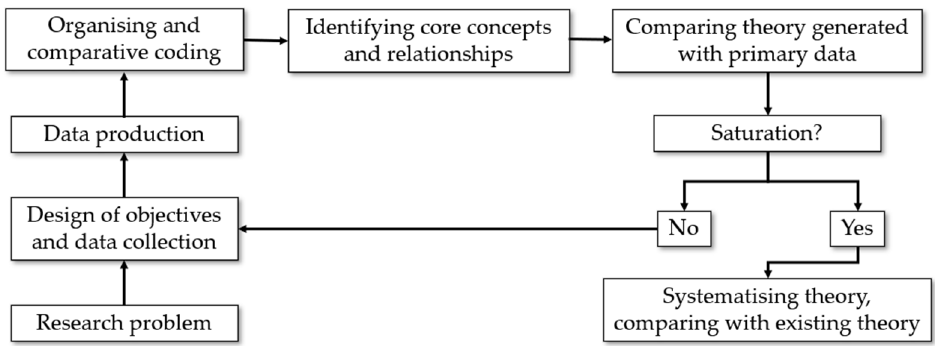
Figure 1. Cyclical scheme of a typical process guided by grounded theory. Table 1. Distribution of the syllabi.